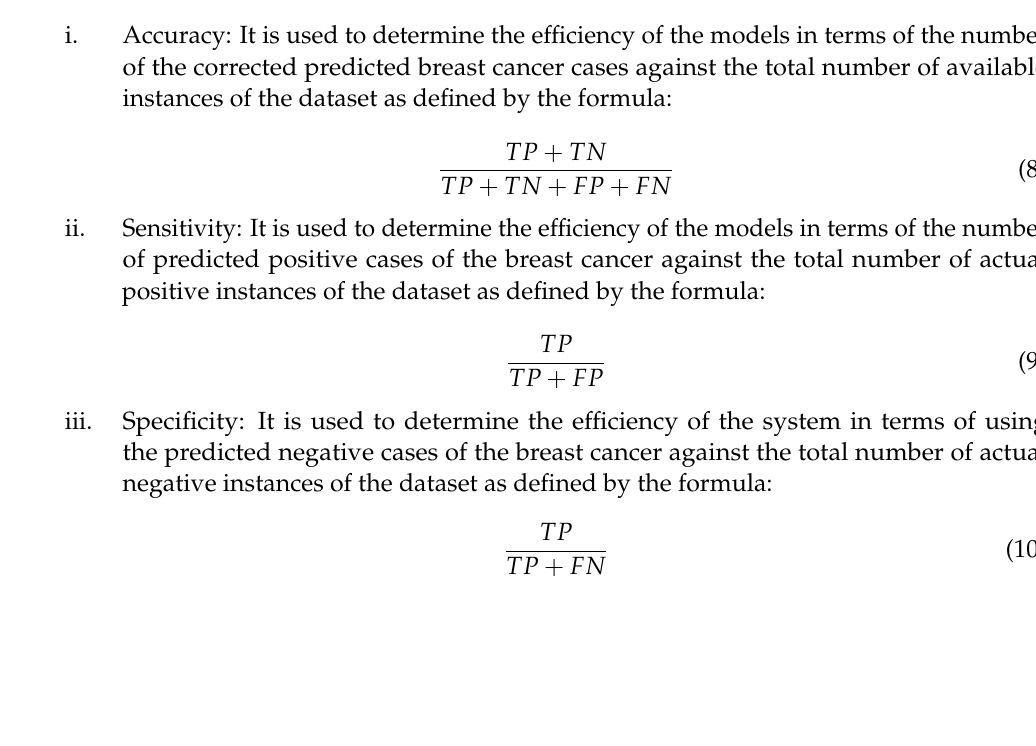
Figure 2. Confusion matric.